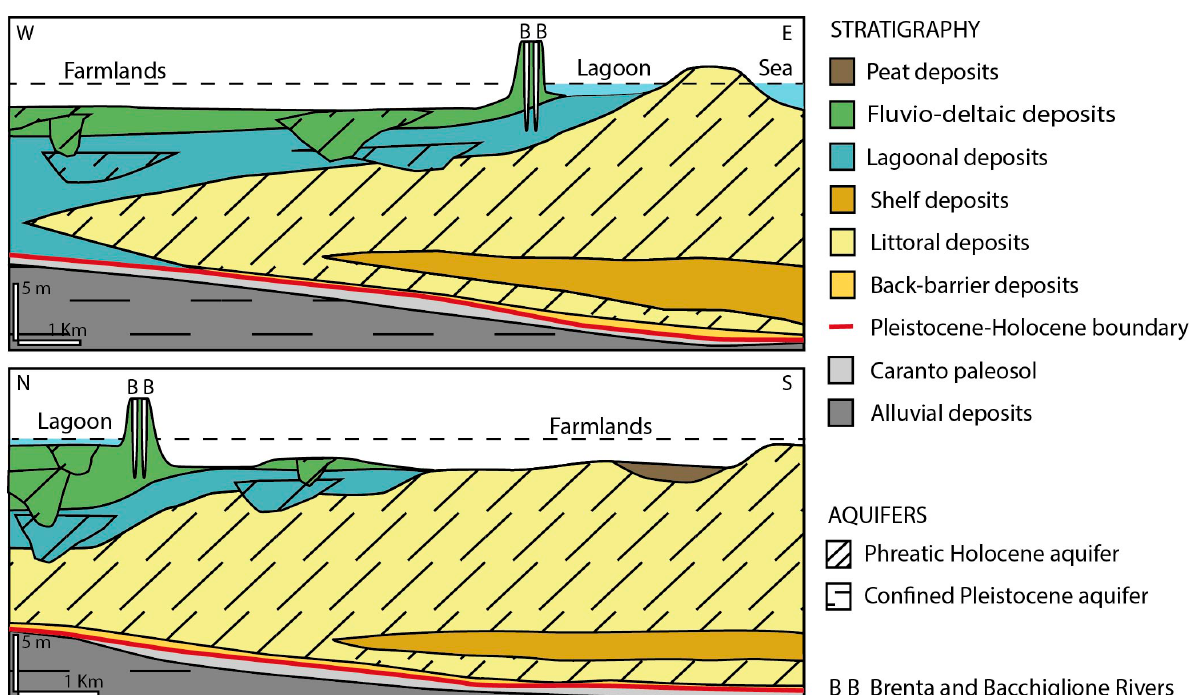
Figure 2. Schematic representation of the hydro-stratigraphic architecture of the study